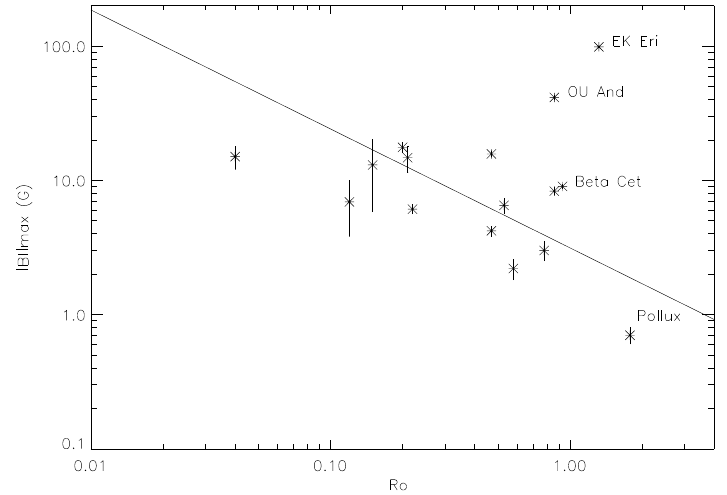
Figure 4. Magnetic field measurements of cool giants of Aurière et al. (2015) [10] over Rossby number—with courtesy of the